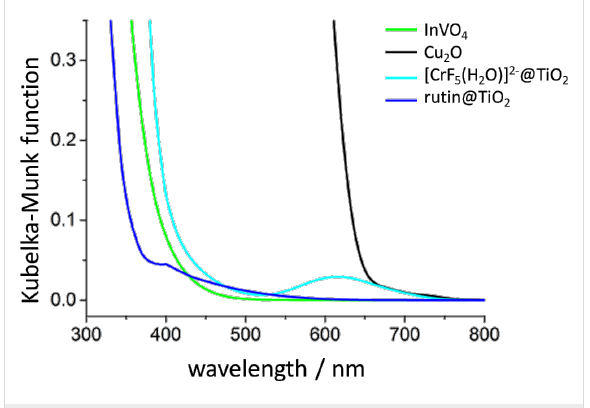
Figure 2: Transformed diffuse reflectance spectra of photocatalysts used in the present